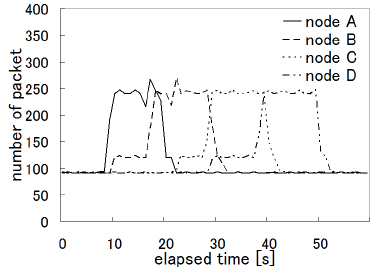
Figure 16 . The number of emitted packets with our